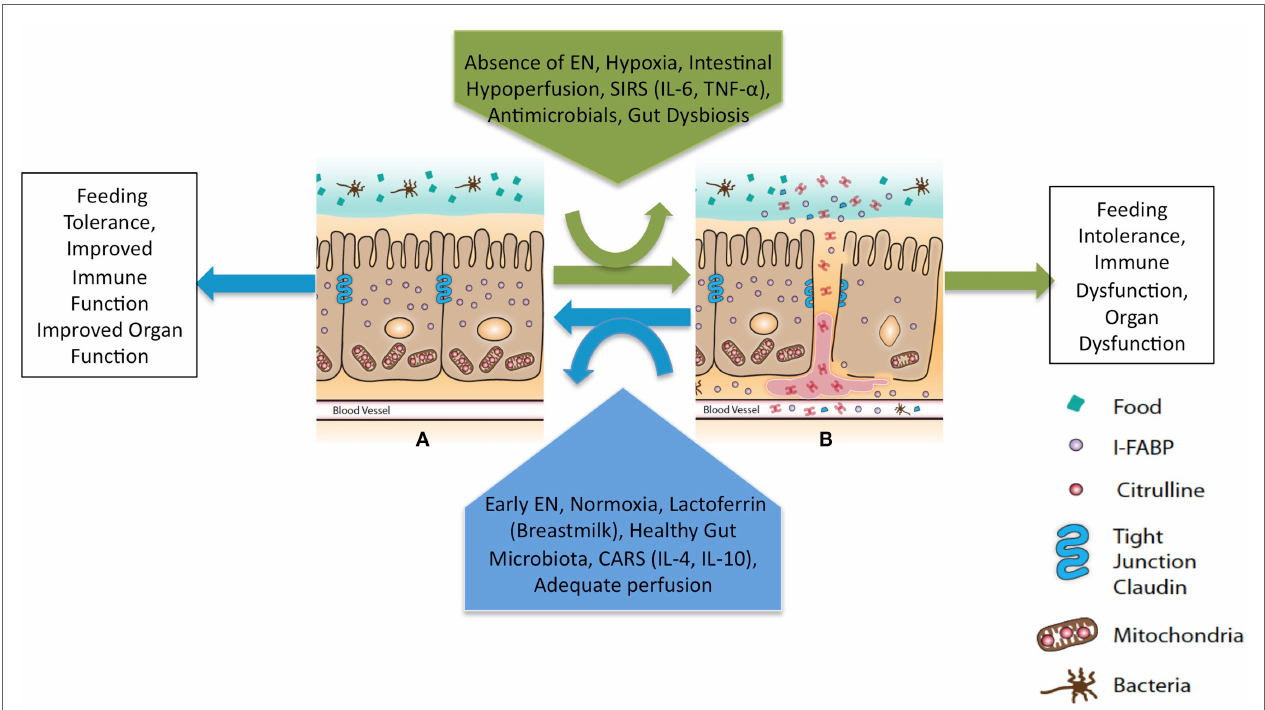
FiGURe 2 | Theoretical framework to maintain intestinal barrier dysfunction in pARDS . EN, enteral nutrition; SIRS, systemic inflammatory response syndrome; CARS, compensatory anti-inflammatory response syndrome . Primary determinants of intestinal barrier function are the apical tight junction complex and the intestinal epithelial cells. Modifiable clinical factors known to modulate intestinal barrier function include EN and antimicrobials. Specific targets for perfusion and oxygenation to improve intestinal barrier function in the setting of pARDS are unknown. The balance of forces will lead to intestinal barrier (A) function or (B) dysfunction and a downstream clinical phenotype with either improved or worsened remote organ (lung)